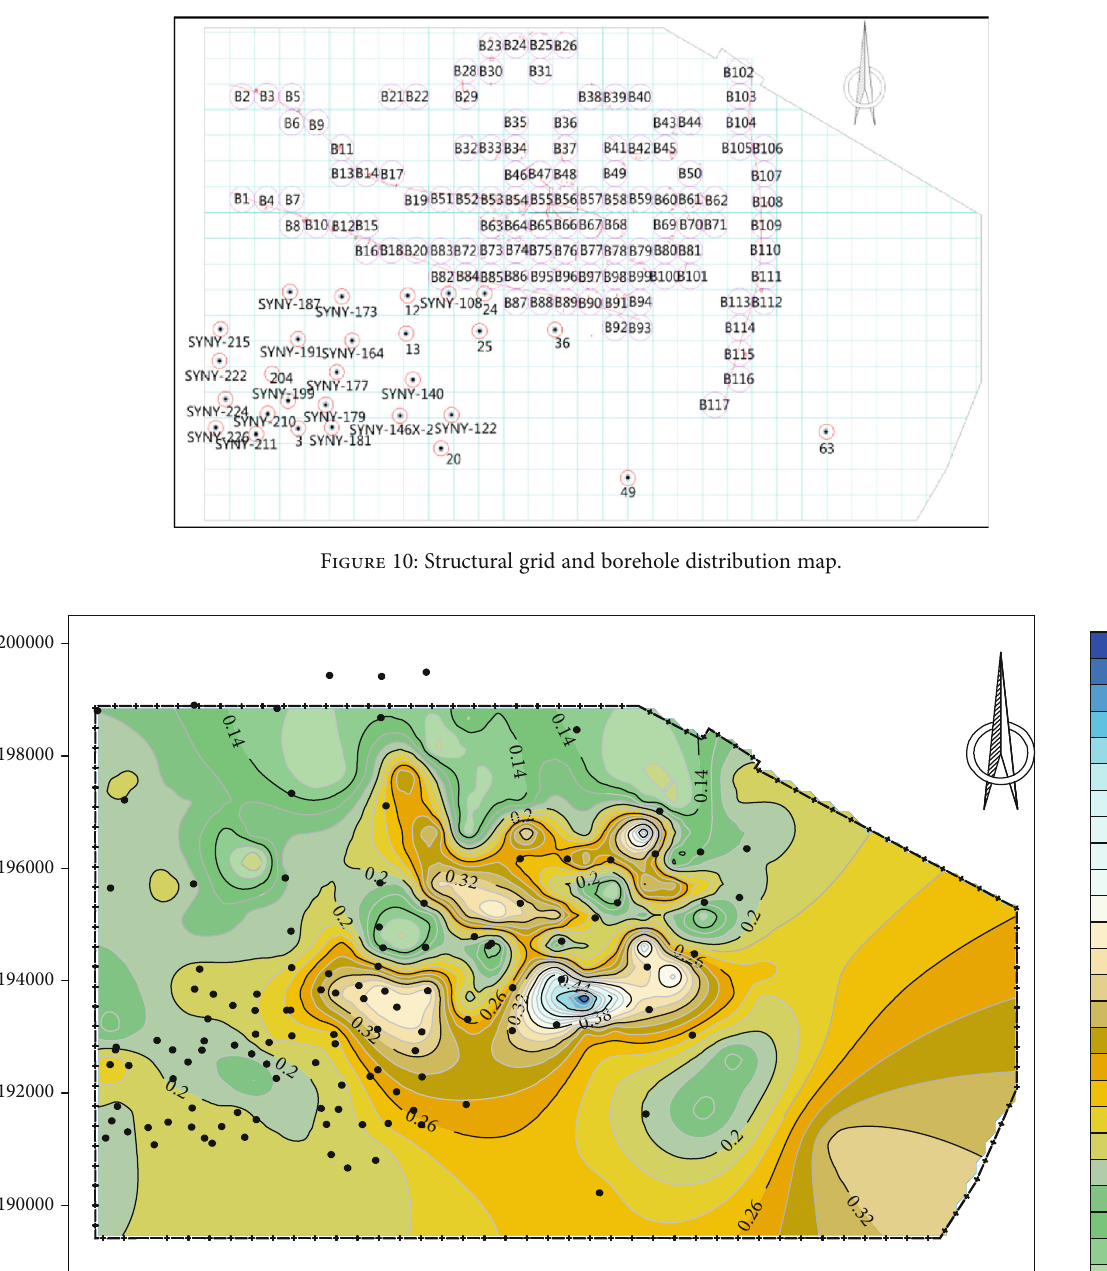
limestone water richness. 2